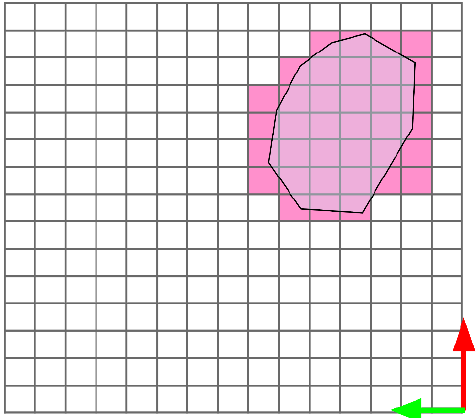
Figure 7. Representation of the rocks’ projection on the XY plane (the red and green arrows represent the X and Y axis, respectively). The magenta grid cells are non-empty (below them there is at least a single point). The white grid cells are empty (below them there are no